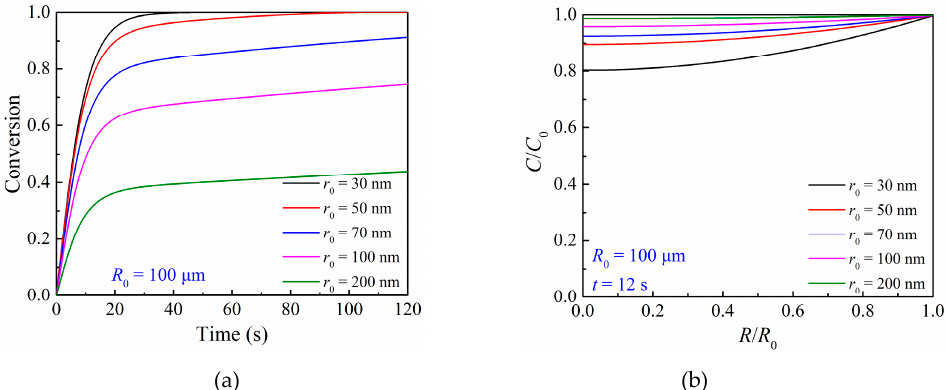
Figure 11. Effects of grain size on ( a ) the overall conversion of the particle and ( b ) oxygen concentration at R / R 0 = 0.5 during the oxidation reaction at 800 °C.